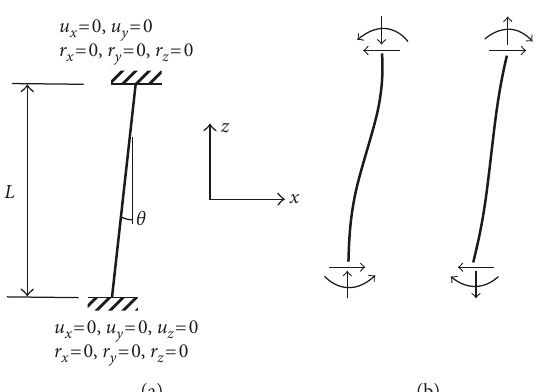
Figure 4: The cyclic load